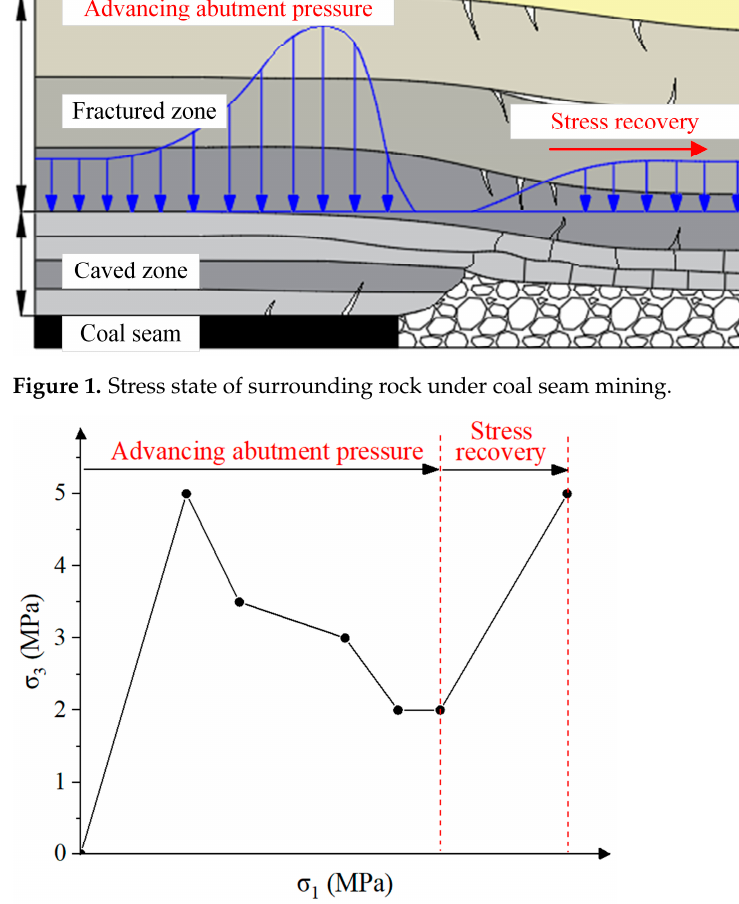
Figure 2. Loading and unloading diagram of mining stress path.